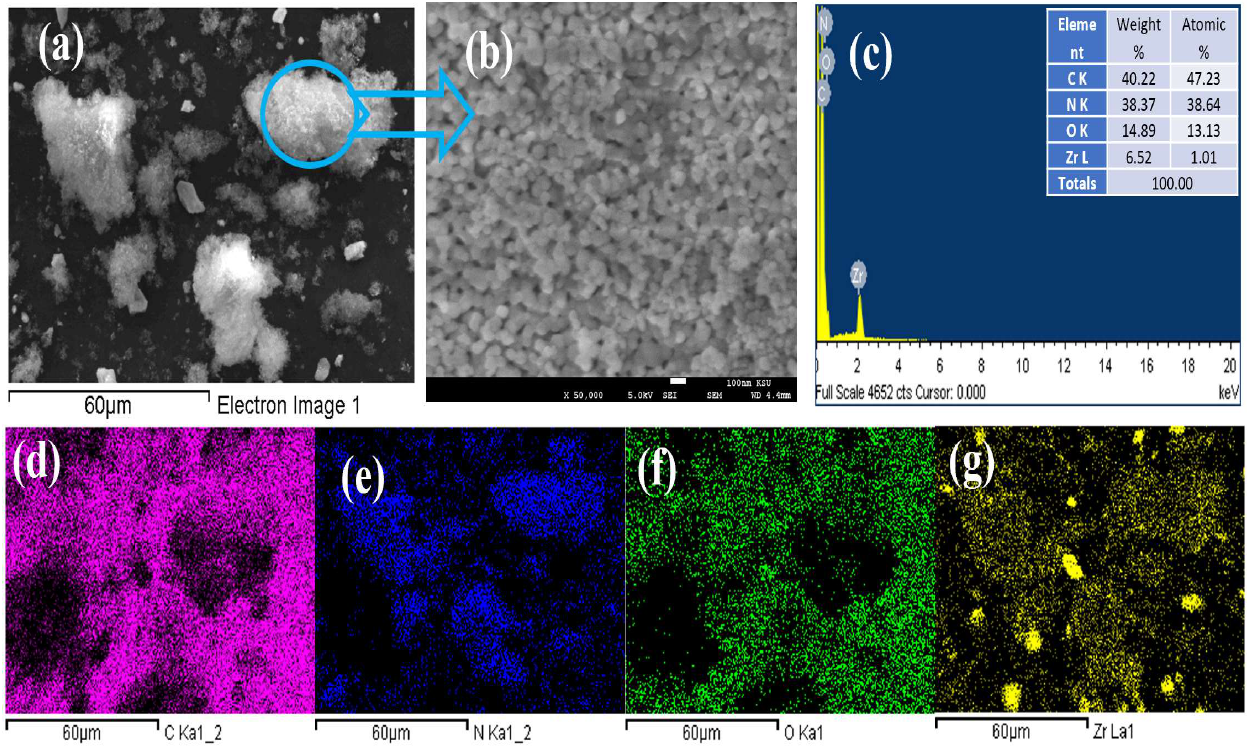
Figure 2. ( a ) SEM image and ( c ) EDX spectrum for element composition; ( b , d – g ) elemental mapping of C, N, O, and Zr, respectively, in Zr-G-C 3 N 4 nanocomposite. Figure 2a reveals smaller elongated particles with smooth surfaces alongside larger aggregates formed by spherical-shaped particles in the nanoscale with homogenous size distribution (Figure 2b). The nanoparticles are interconnected, forming a mesoporous network nanostructure all over the material, generated from the thin hysteresis loop spawning, which is convenient with the BET analysis manifesting a type II isotherm [18]. The EDS spectrum of Zr-G-C 3 N 4 (Figure 2c) contains the peaks related to C, N, O, and Zr, confirming once again that the purity of the as-fabricated nanocomposite material made of graphitic carbon nitride and zirconium oxide corroborates the literature [18,19], and EDS elemental mapping indicates homogenous distribution Figure 2d–g.